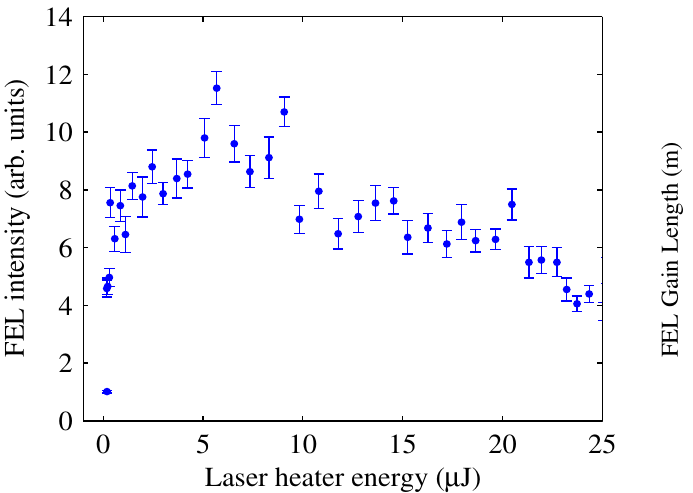
FIG. 16. (Color) FEL gain length at 1.5 A˚ vs LH-induced energy